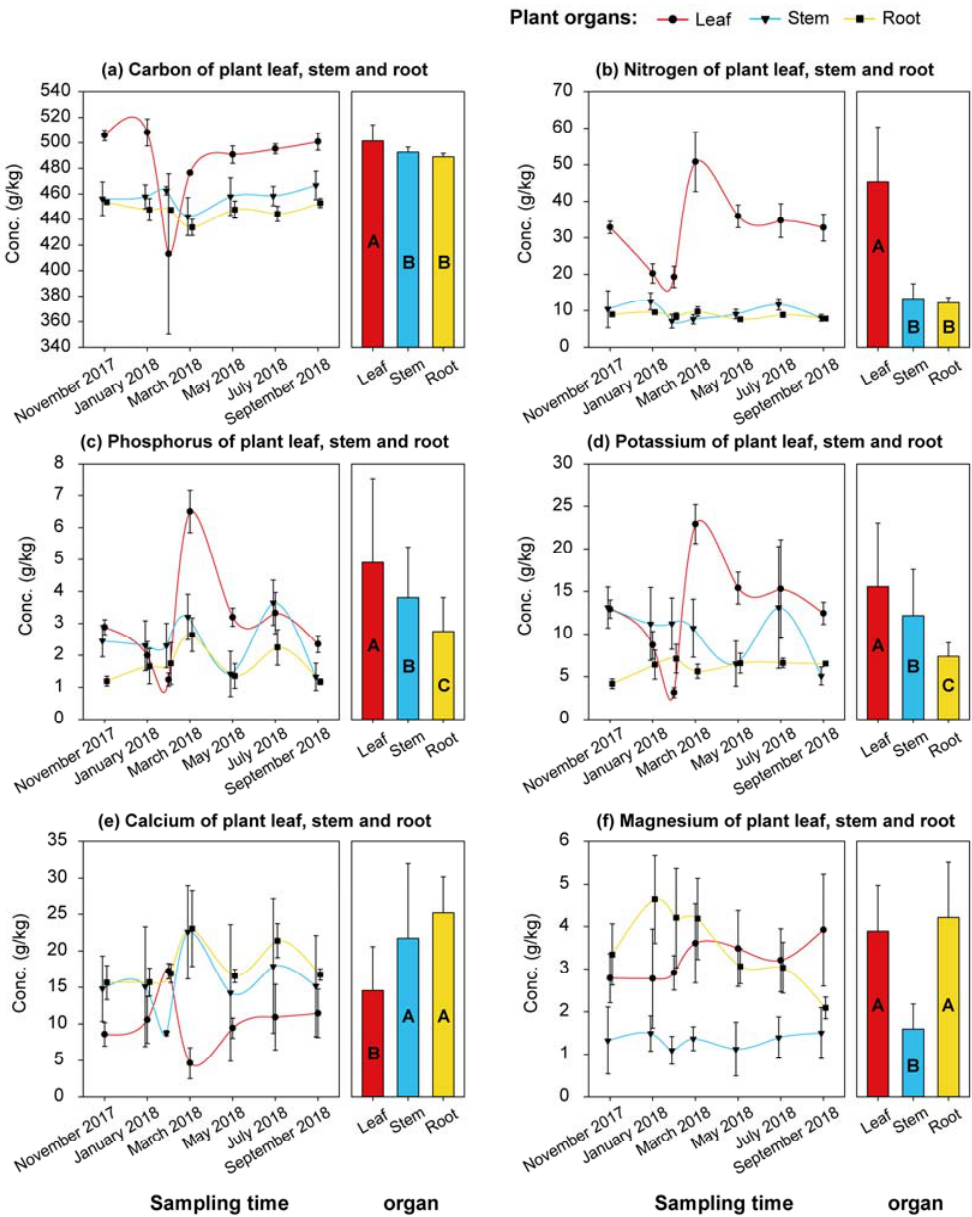
Figure 5. Variations in the concentrations of ( a ) carbon, ( b ) nitrogen, ( c ) phosphorus, ( d ) potassium, ( e ) calcium, and ( f ) magnesium in the leaves, stems, and roots of rubber trees. Different uppercase letters indicate significant differences among plant organs ( p ≤ 0.01).